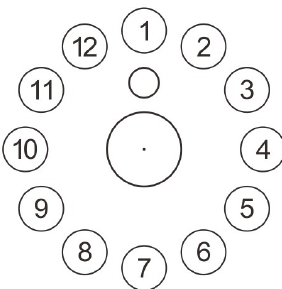
Figure 2. 12-bit mark point decoding order.